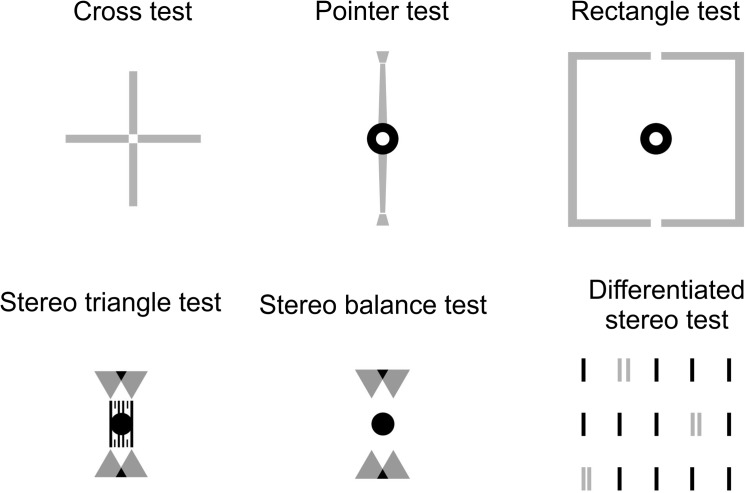
The MCH-method for prescribing prisms.Six different test plates are applied at a 6 m viewing distance. Black parts are binocularly visible fusion targets, grey parts are presented dichoptically (i.e., separately to the two eyes). For scale: each of the four lines in the Cross test is 1.2 deg long.